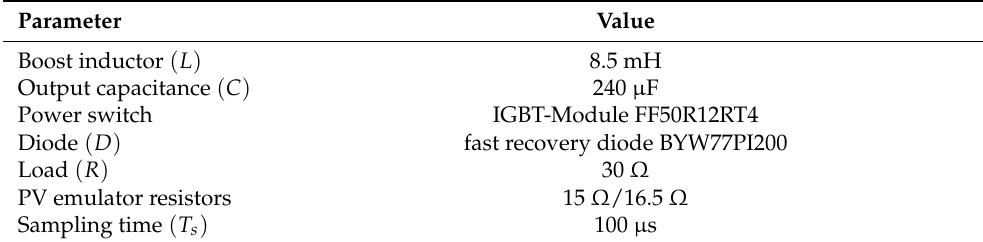
Figure 6. The experimental configuration of the PV system and HIL. Table 3. The parameters of the experimental